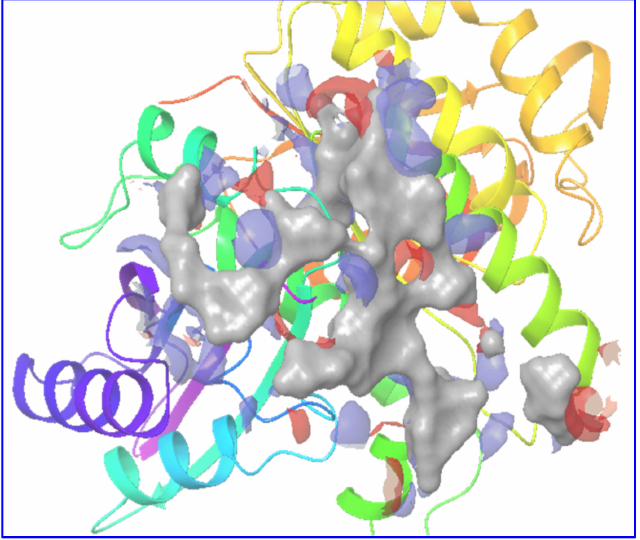
Figure 2. The figure shows the grid formed around the receptor Fts-Z (PDB ID 2VXY), taking the site map tool’s predictions. Site points (presented on grey surface) for the potential binding site (site-1). The site score was 0.911 with a size of 791. Dscore- was 1.028, Volume—558.061, HB don./acc.—1.401, Hydrophilic—0.185,